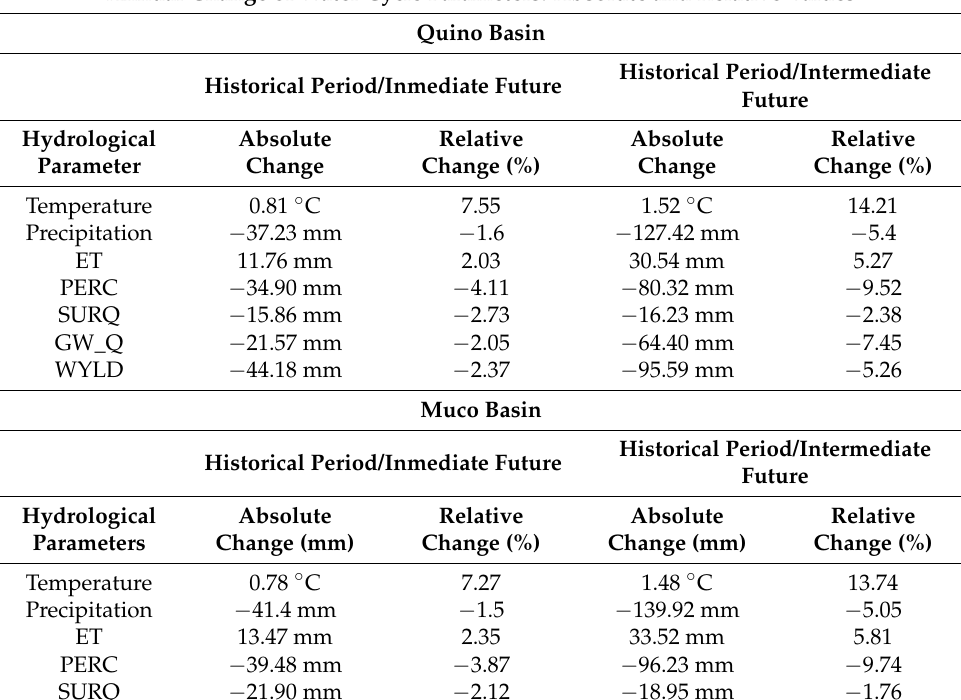
Table 2. Annual absolute and relative change. Climate model RegCM4-MPI-ESM-MR projection